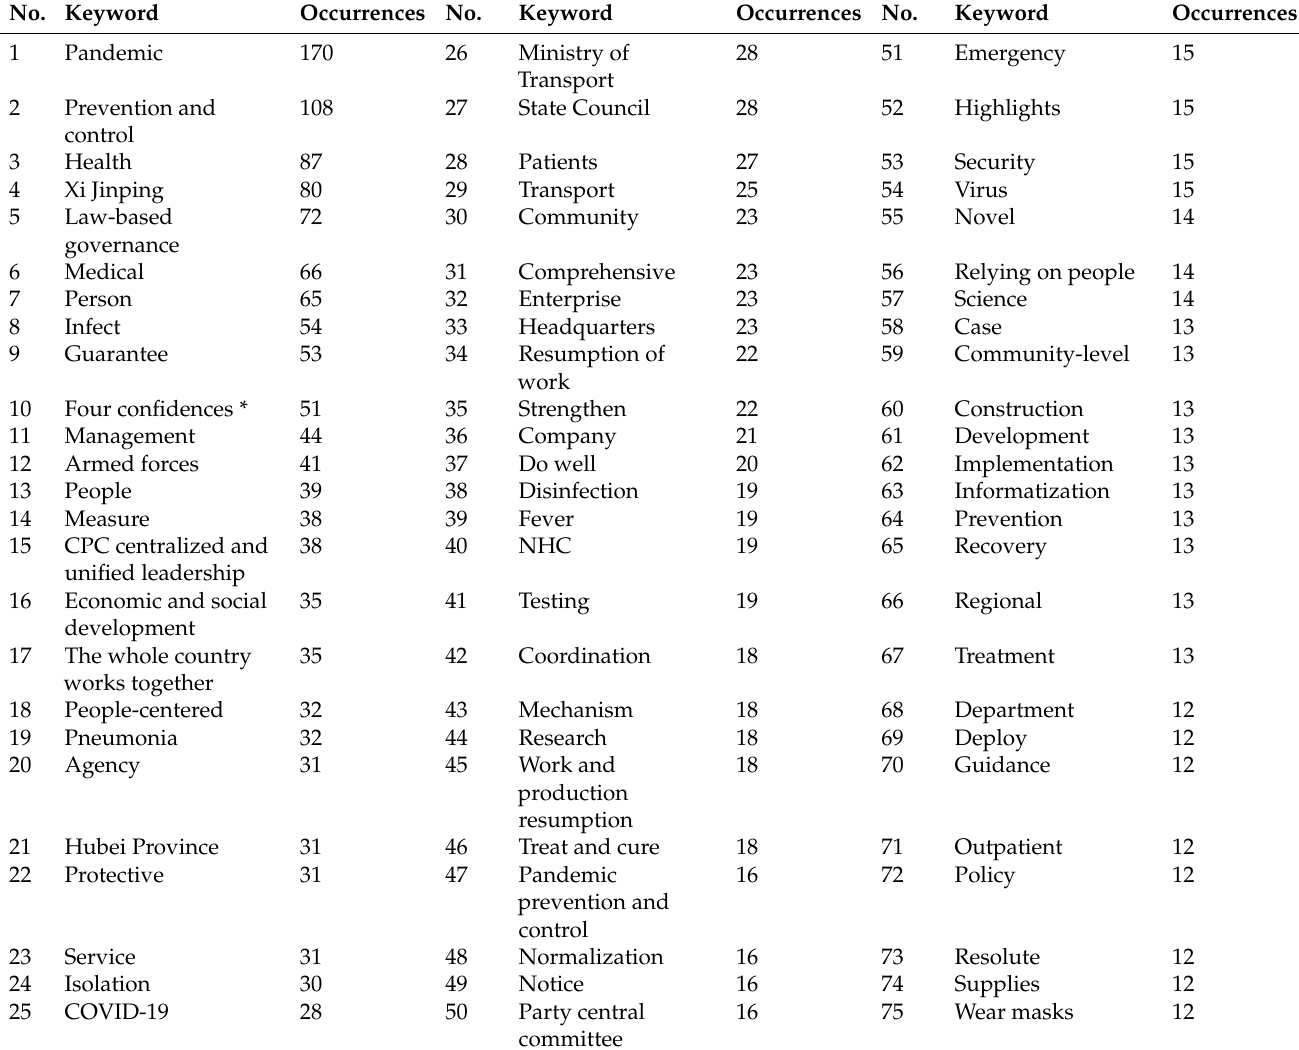
Table 2. Word occurrence statistics in the COVID-19 pandemic prevention and control policies ( n =